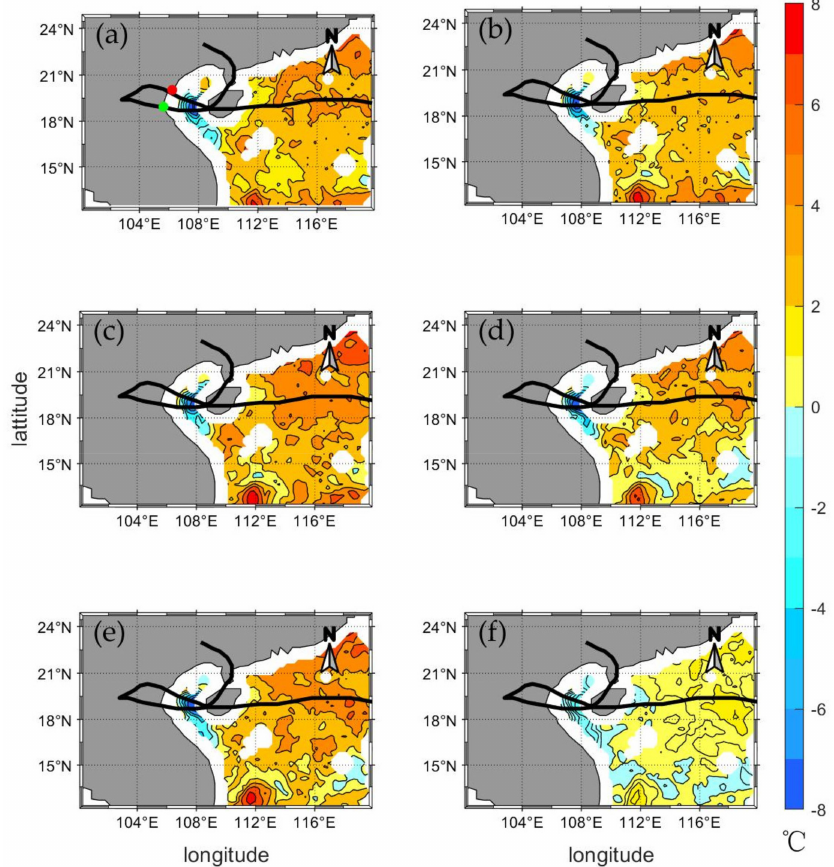
Figure 10. Temperature change after typhoon Son-tinh in 2018: ( a ) Describes the change of SSTA on the first day after the typhoon, the green dot represents the typhoon center at 18:00 on 18 July, the red dot represents the typhoon center at 6:00 on 21 July; ( b – f ) Describes the change of SSTA on 2–6 day after the